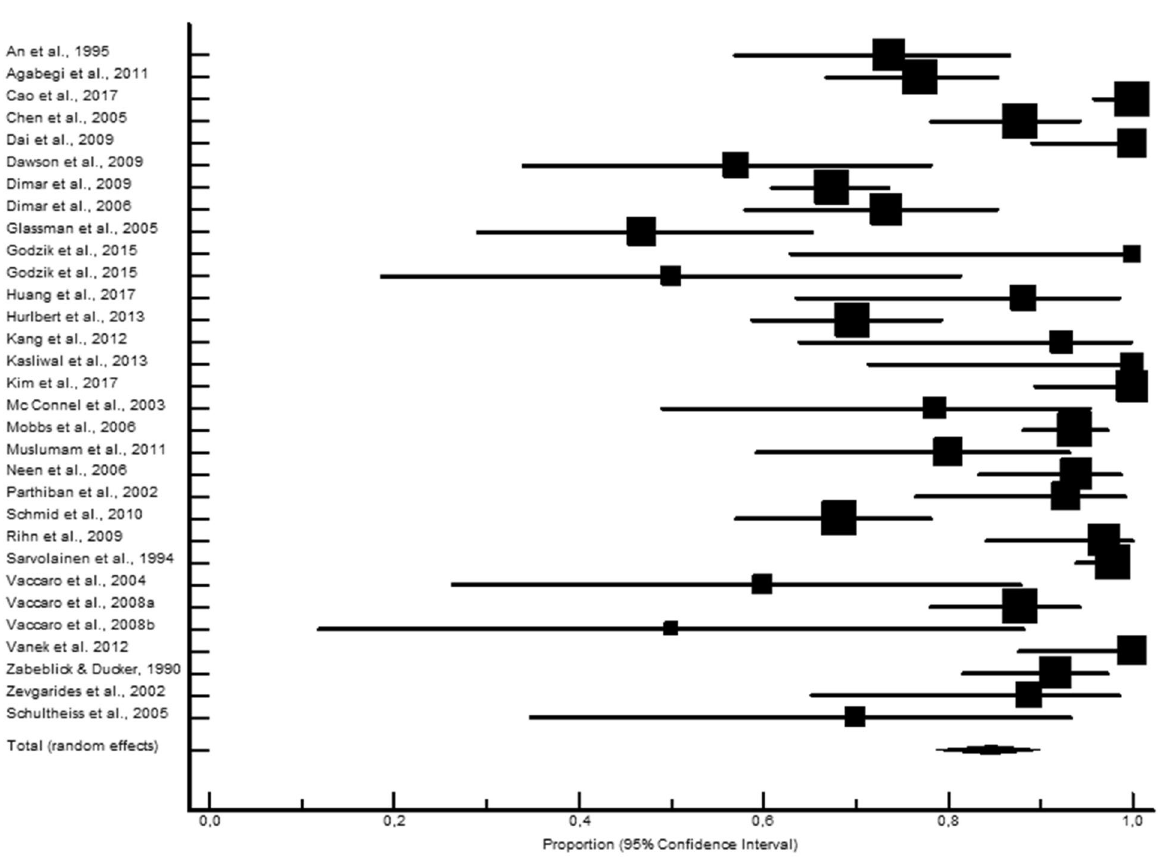
Figure 2. Autologous iliac crest pooled proportional rate for spinal fusion.